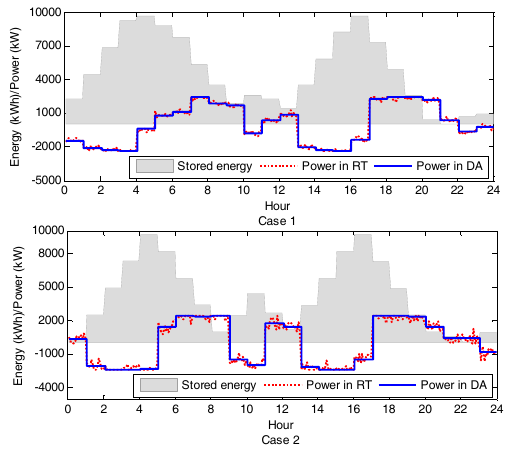
Figure 5. Computation performances for Cases 1 and 2.